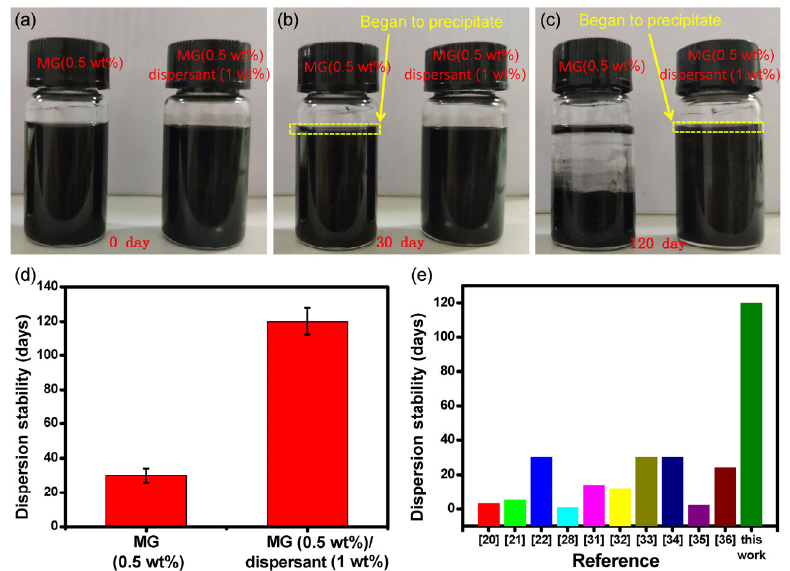
Fig. 2 (a–c) Photos of solution appearance in different time and (d) dispersion stability of MG (0.5 wt%) and MG (0.5 wt%)/dispersant